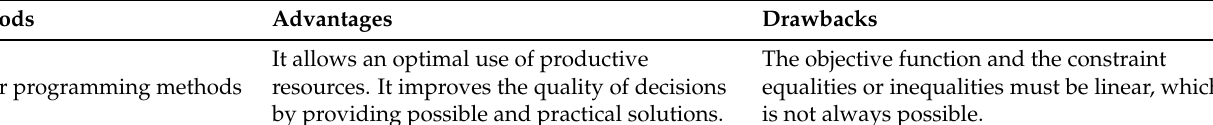
Table 3. Advantages and disadvantages of optimization methods for